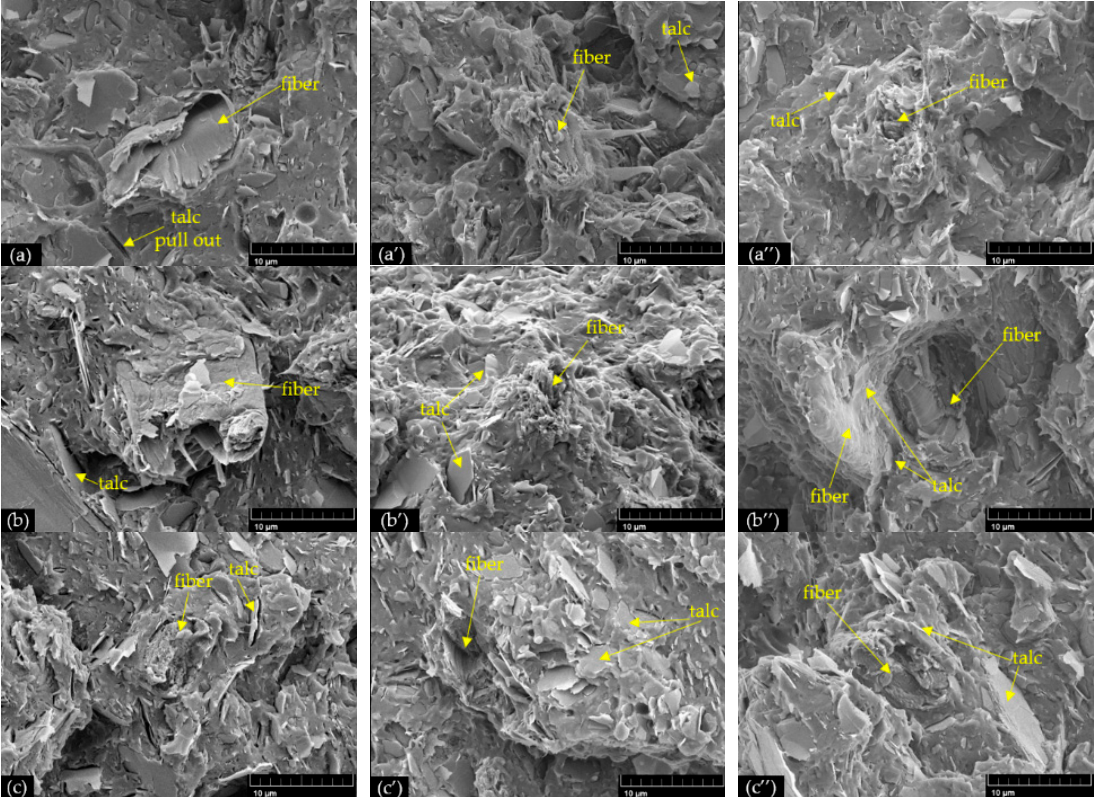
Figure 3. Tensile fracture surfaces of PLA hybrid composites with and without